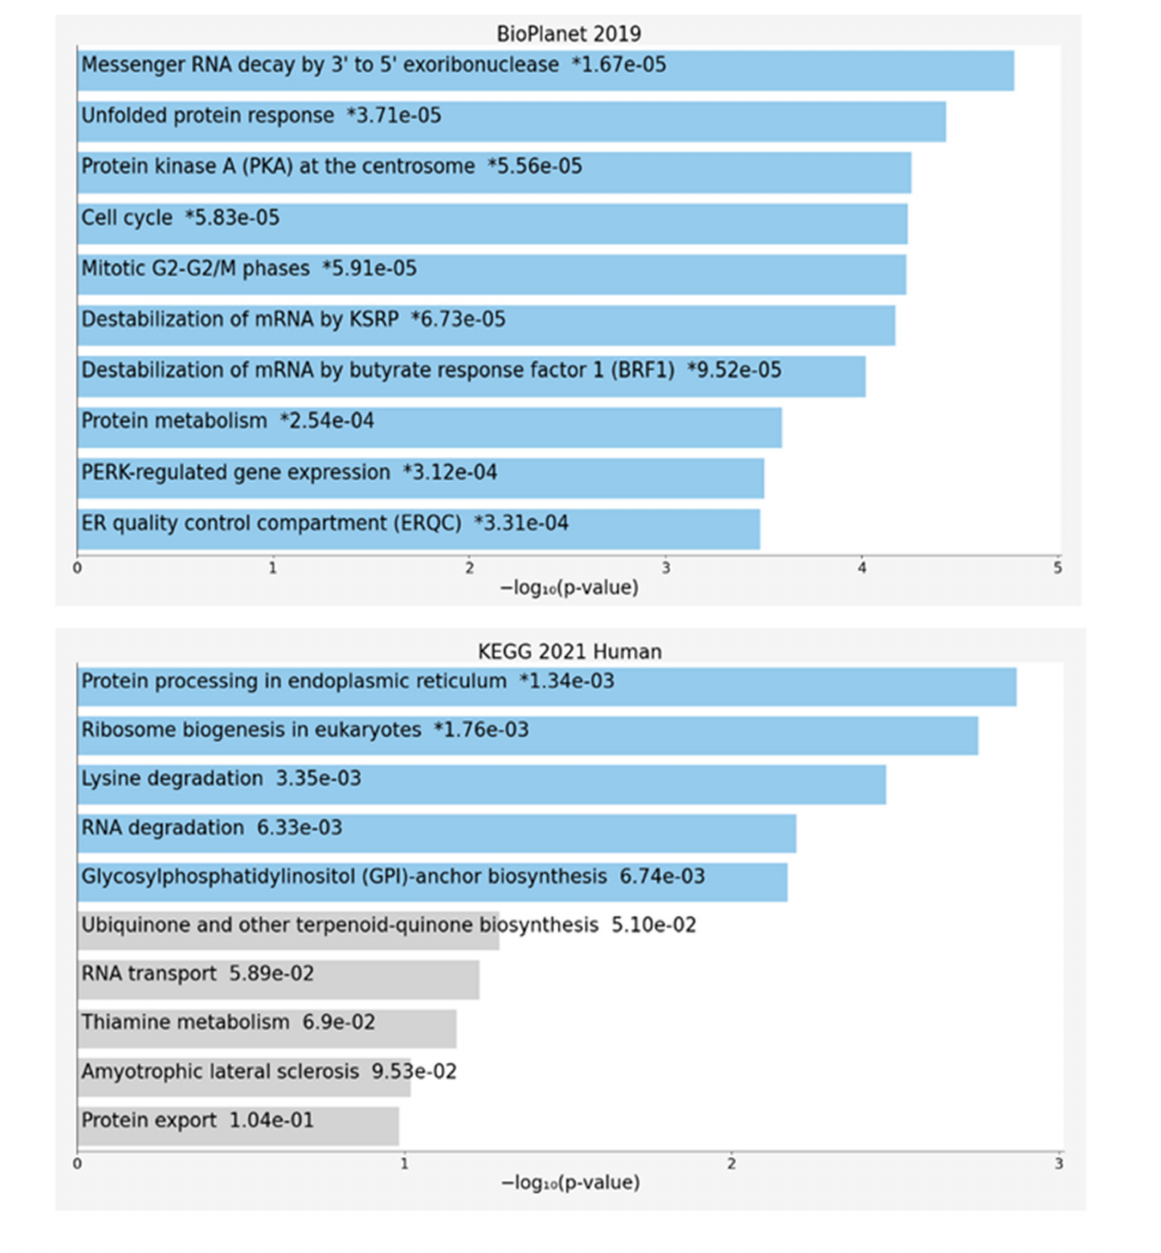
Figure 4. Disease-based enrichment analysis through the Enrichr web server [20–22]. Gene set enrichment analysis of the top 10 genes on the 30 F-SARC-CoV ( a ) and 95 CONTROL ( b ) genes sets crossing with the SARS-CoV2 GHI interactome. The bar chart shows the top 10 enriched terms in the chosen library, with their corresponding p -values. Colored bars correspond to terms with significant p -values (<0.05). An asterisk (*) next to a p -value indicates the term also has a significant adjusted p -value (<0.05). The data presented used two databases, BIOPLANET-2019 (NIH-USA, National Center for Advancing Translational Science) and KEGG-2021 (Kyoto Encyclopedia of Genes and